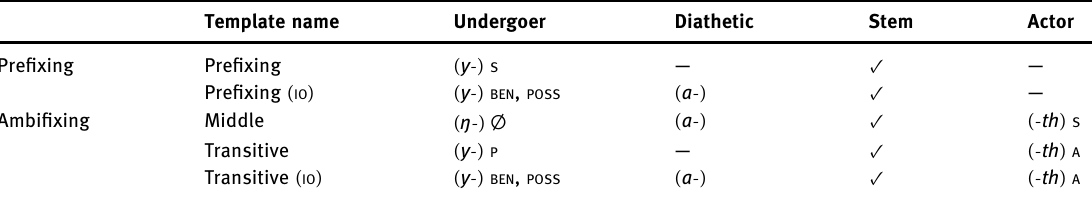
Table 3: Verb templates